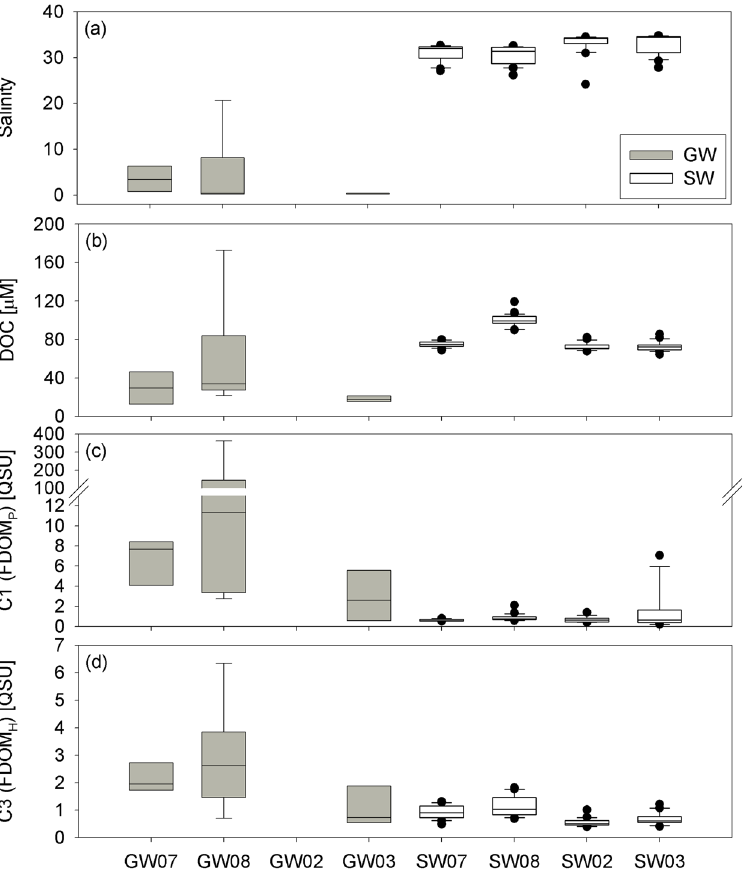
Figure 3. Box plots showing ( a ) salinity, ( b ) DOC, ( c ) FDOM P , and ( d ) FDOM H in the groundwater (GW) and coastal seawater (SW) of Jochun Bay during four sampling